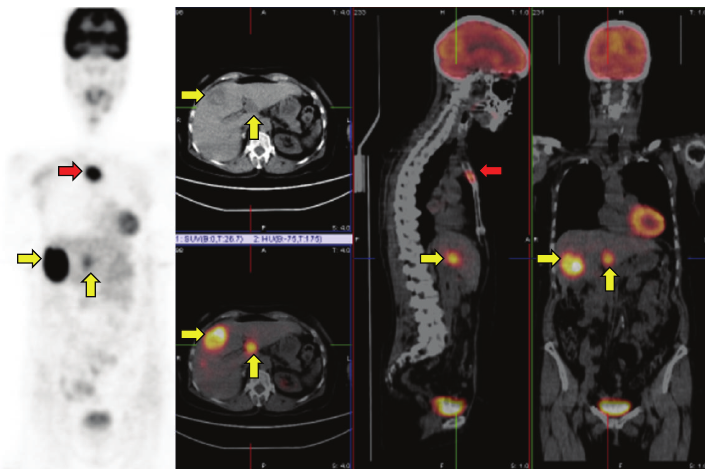
Figure 1: FDG-PET/CT in a 68-year-old female previously operated for HCTC showing the presence of sternal (red arrows) and liver metastases (yellow